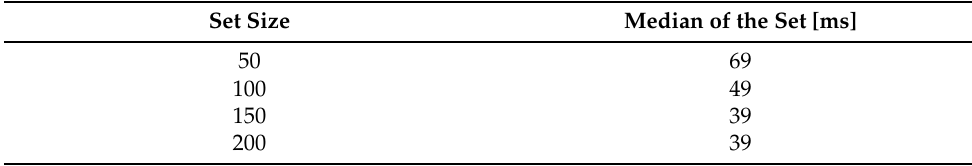
Table 3. Tthreshold for different sizes of mining